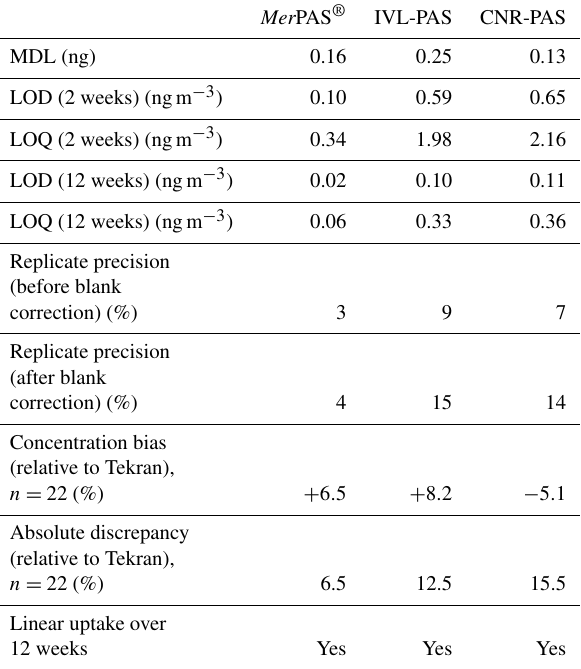
Table 4. Summary of the key metrics describing the performance of the three passive air samplers for Hg as determined in this